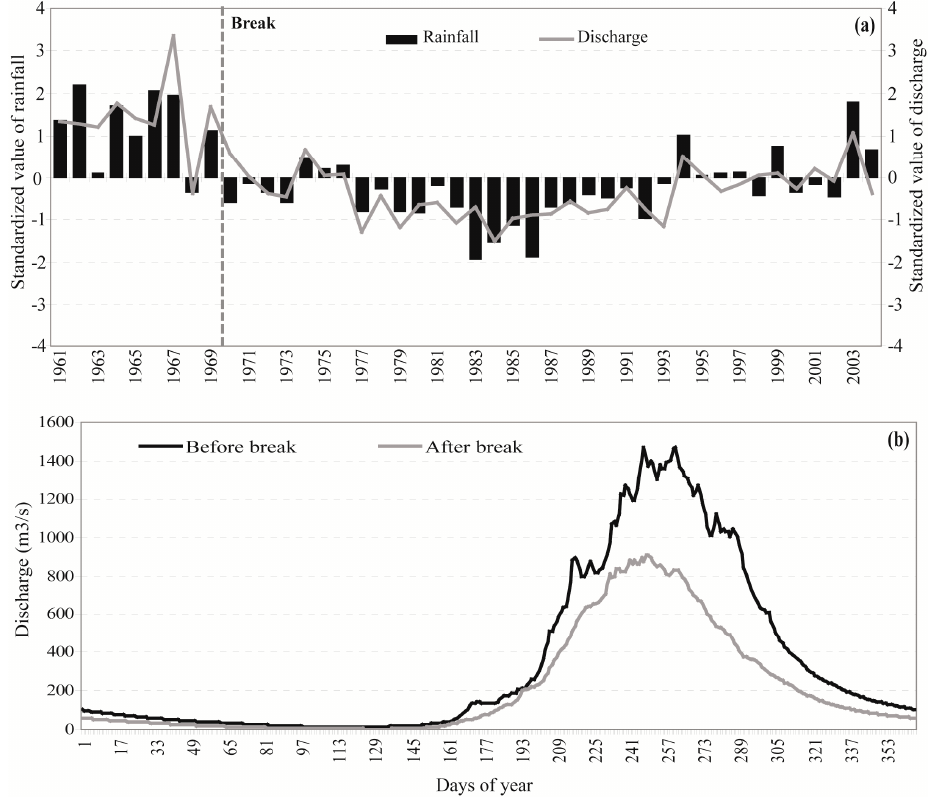
Figure 3. Disruption in hydro-climate series: ( a ) standard rainfall and flow anomalies; ( b ) seasonal cycles of pre-/post-disruption runoffs. Table 3. The hydrological calibration